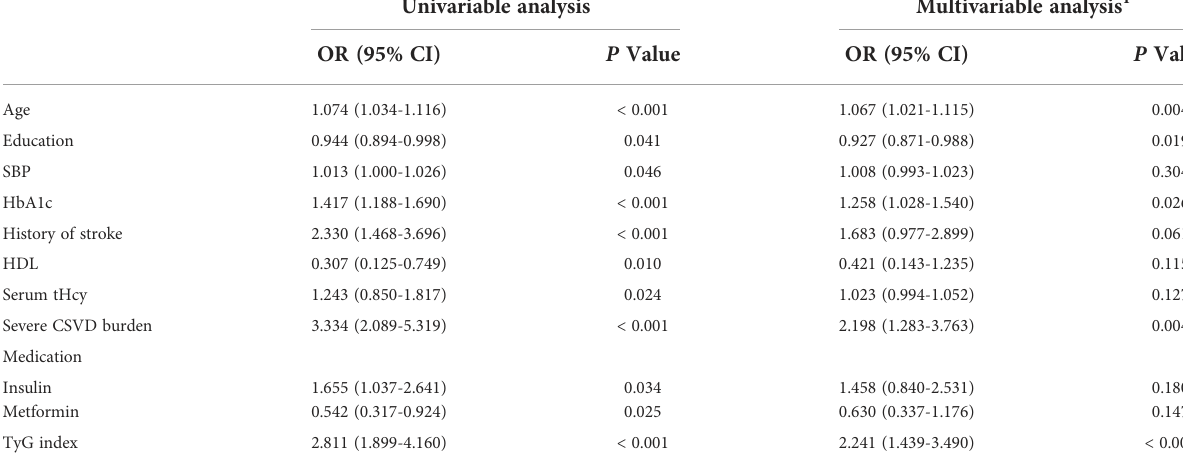
TABLE 2 The logistic regression analyses between possible predictors and cognitive